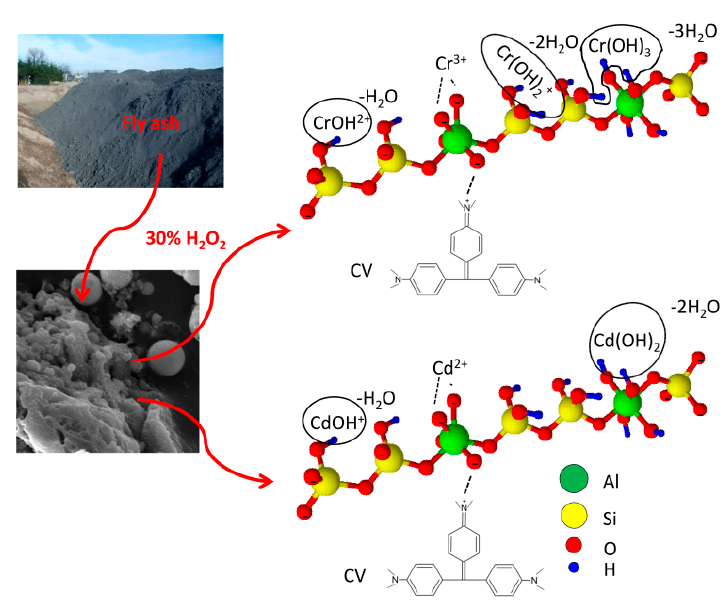
Figure 7. Schema of different mechanisms of the sorption process of Cr(III), Cd(II) and crystal violet (CV) onto FA–H 2 O 2 .